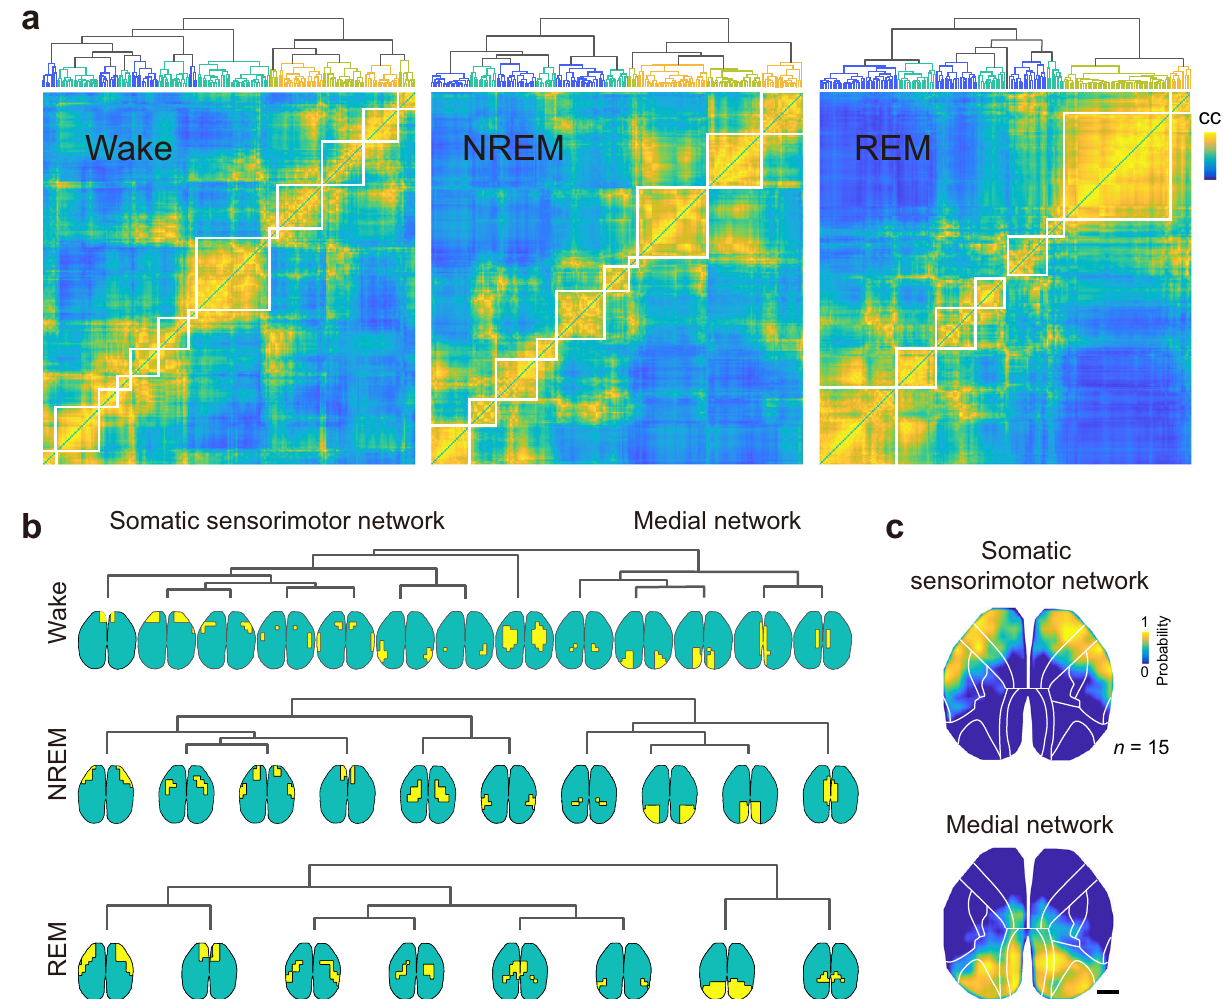
Fig. 2 | Anterior-posterior organization of cortical activity during sleep. a Regional activity correlation matrix during Wake (left), NREM (middle), and REM (right)inoneexamplerecording(~70min).Thepairwisecorrelationwascomputed using neural activity during Wake, NREM, or REM in each small patch (~10 ×10 pixels)ofthebrainregion.Brainregionswithsimilaractivitypro fi lesweregrouped score the brain states, we performed fast Fourier transforms (FFTs) on EEG to extract the δ (0.5 − 4 Hz) and θ (6 − 10Hz) activity. Brain states